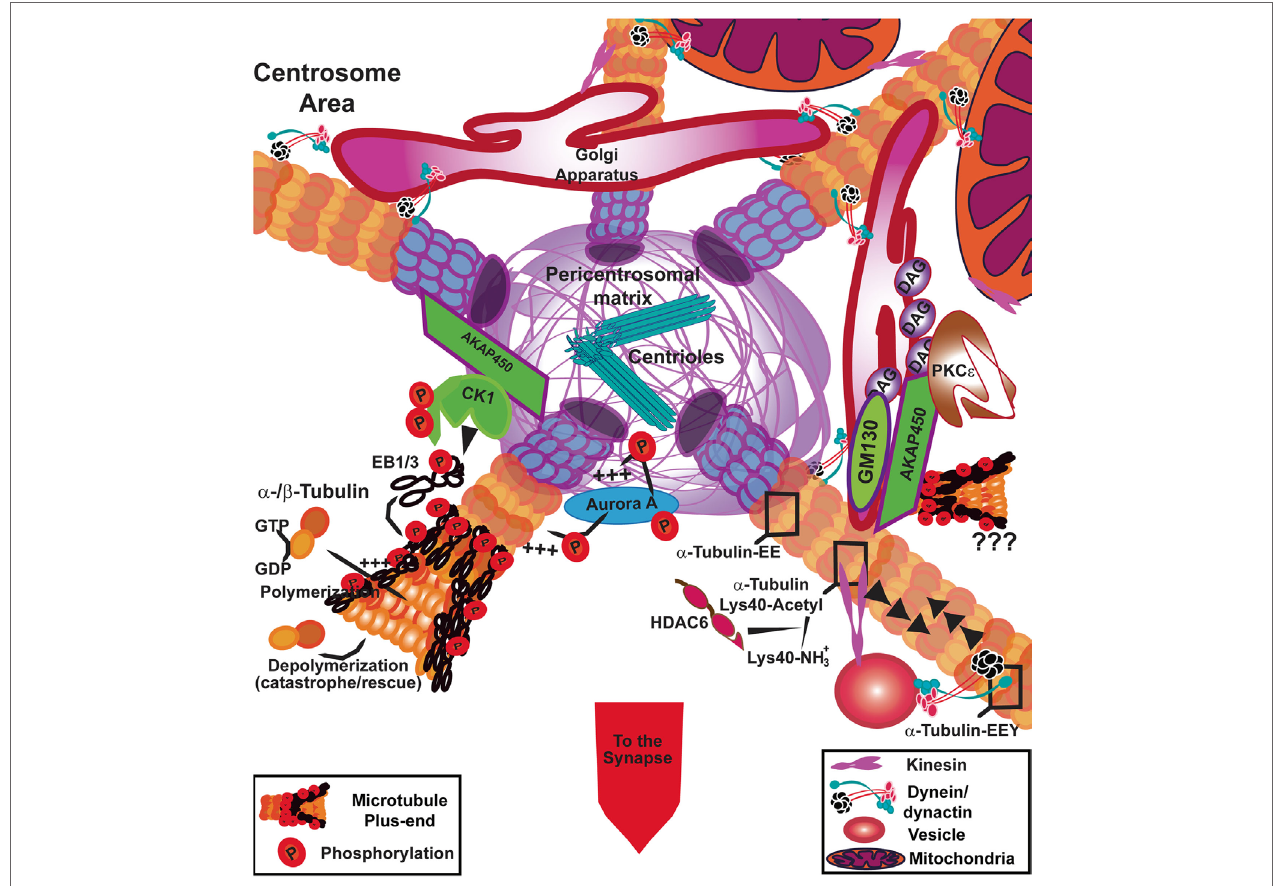
FigURe 3 | Signaling at the centrosome area to fuel tubulin polymerization. In T cells, the polymerization of microtubules (MTs) from the centrosome is controlled by casein kinase I δ (CKI δ ) through phosphorylation of end-binding 1 (EB1). AKAP450 anchors CKI to the pericentrosomal matrix. Aurora A also promotes the incorporation of α / β -tubulin heterodimers into MTs at the centrosome through its kinase activity. AKAP450 can also dock at the Golgi apparatus where it may collaborate with GM130 to facilitate tubulin polymerization. The Golgi apparatus is formed by diacylglycerol (DAG)-enriched membranes, where protein kinase C (PKC) ε anchors. AKAP450 binds to hypophosphorylated PKC ε , which can constitute a reservoir for the non-activated kinase. The post-translational modifications of the MTs can affect the binding of molecular motors; kinesin likely interacts preferentially with acetylated MTs and dynein/dynactin interact with tyrosinated MT ( α -tubulin-EEY) through dynactin binding, although dynein can move along detyrosinated ( α -tubulin-EE) and tyrosinated MTs. Both motors are in charge of movement around the centrosomal area, of organelles such as vesicles and mitochondria, whereas dynein is the main responsible for Golgi apparatus shape and stability. The images in the figure are not